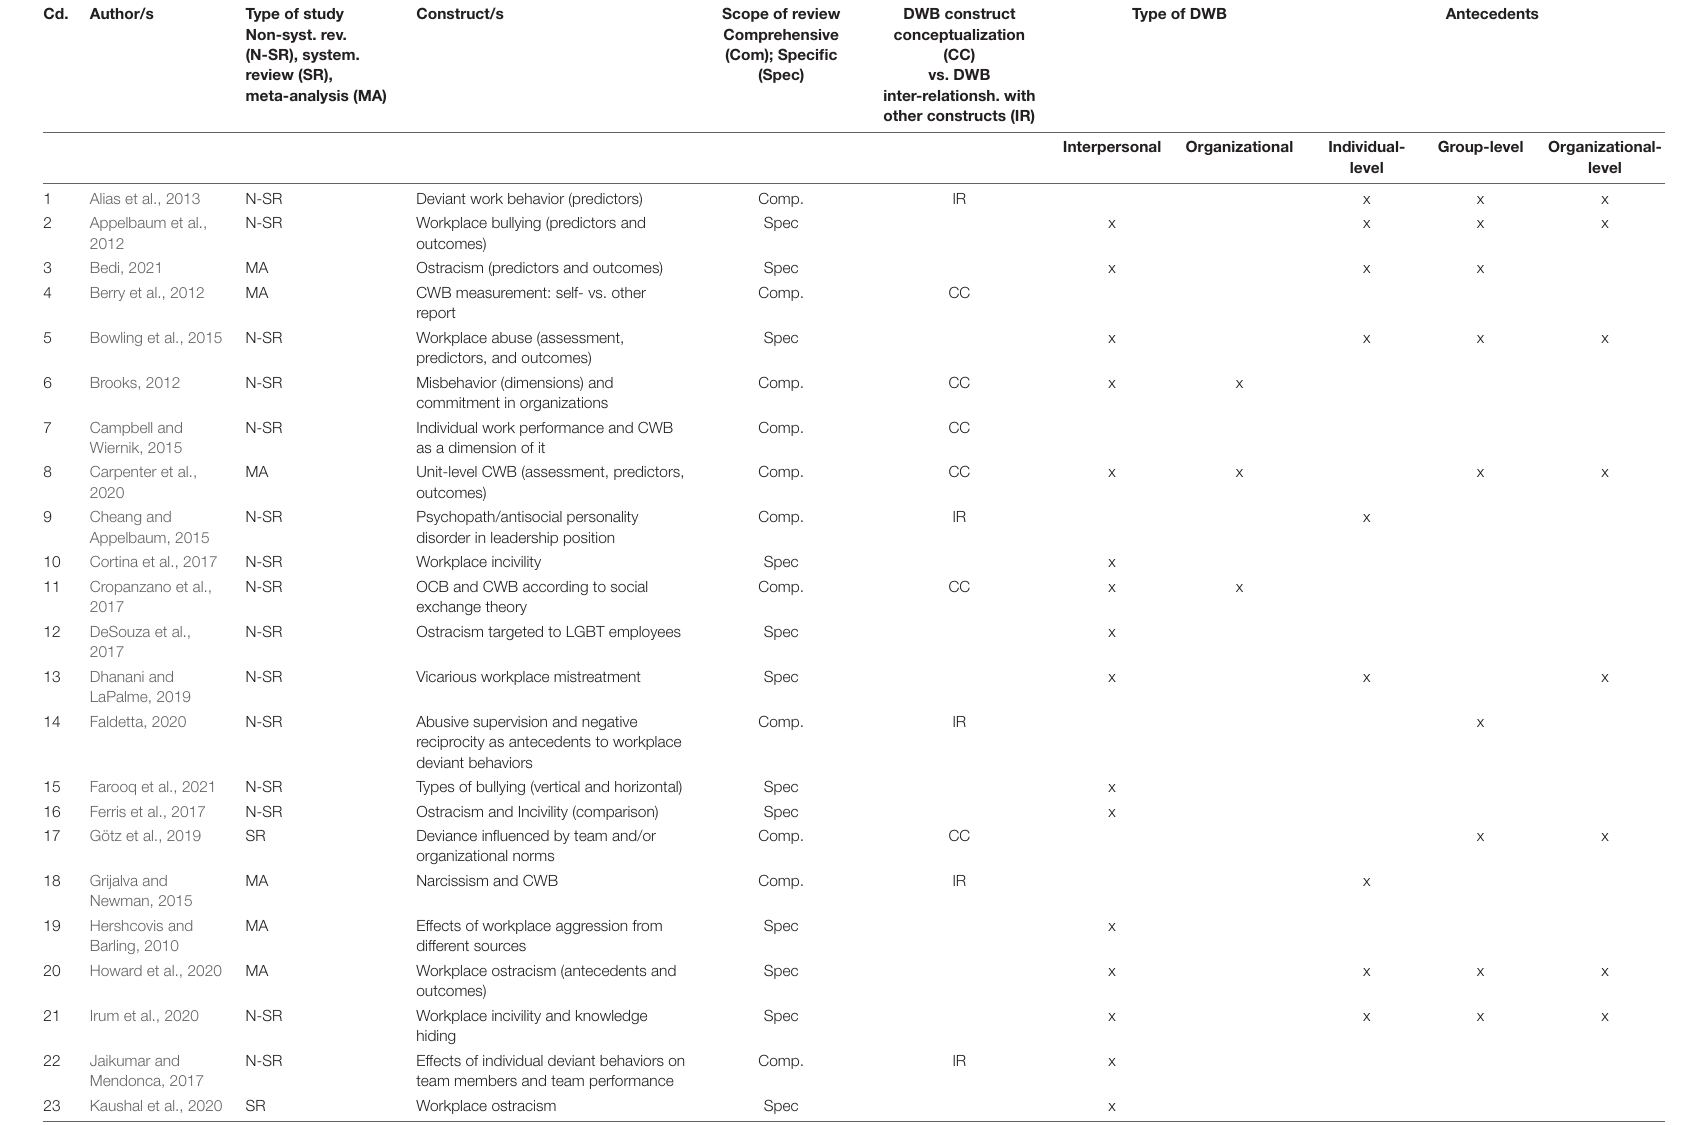
TABLE 1 | Overview of included